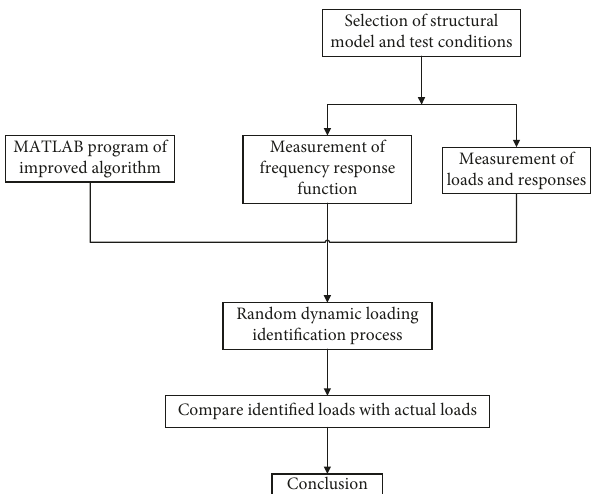
Figure 1: Flow chart of improved random dynamic loading identification method.